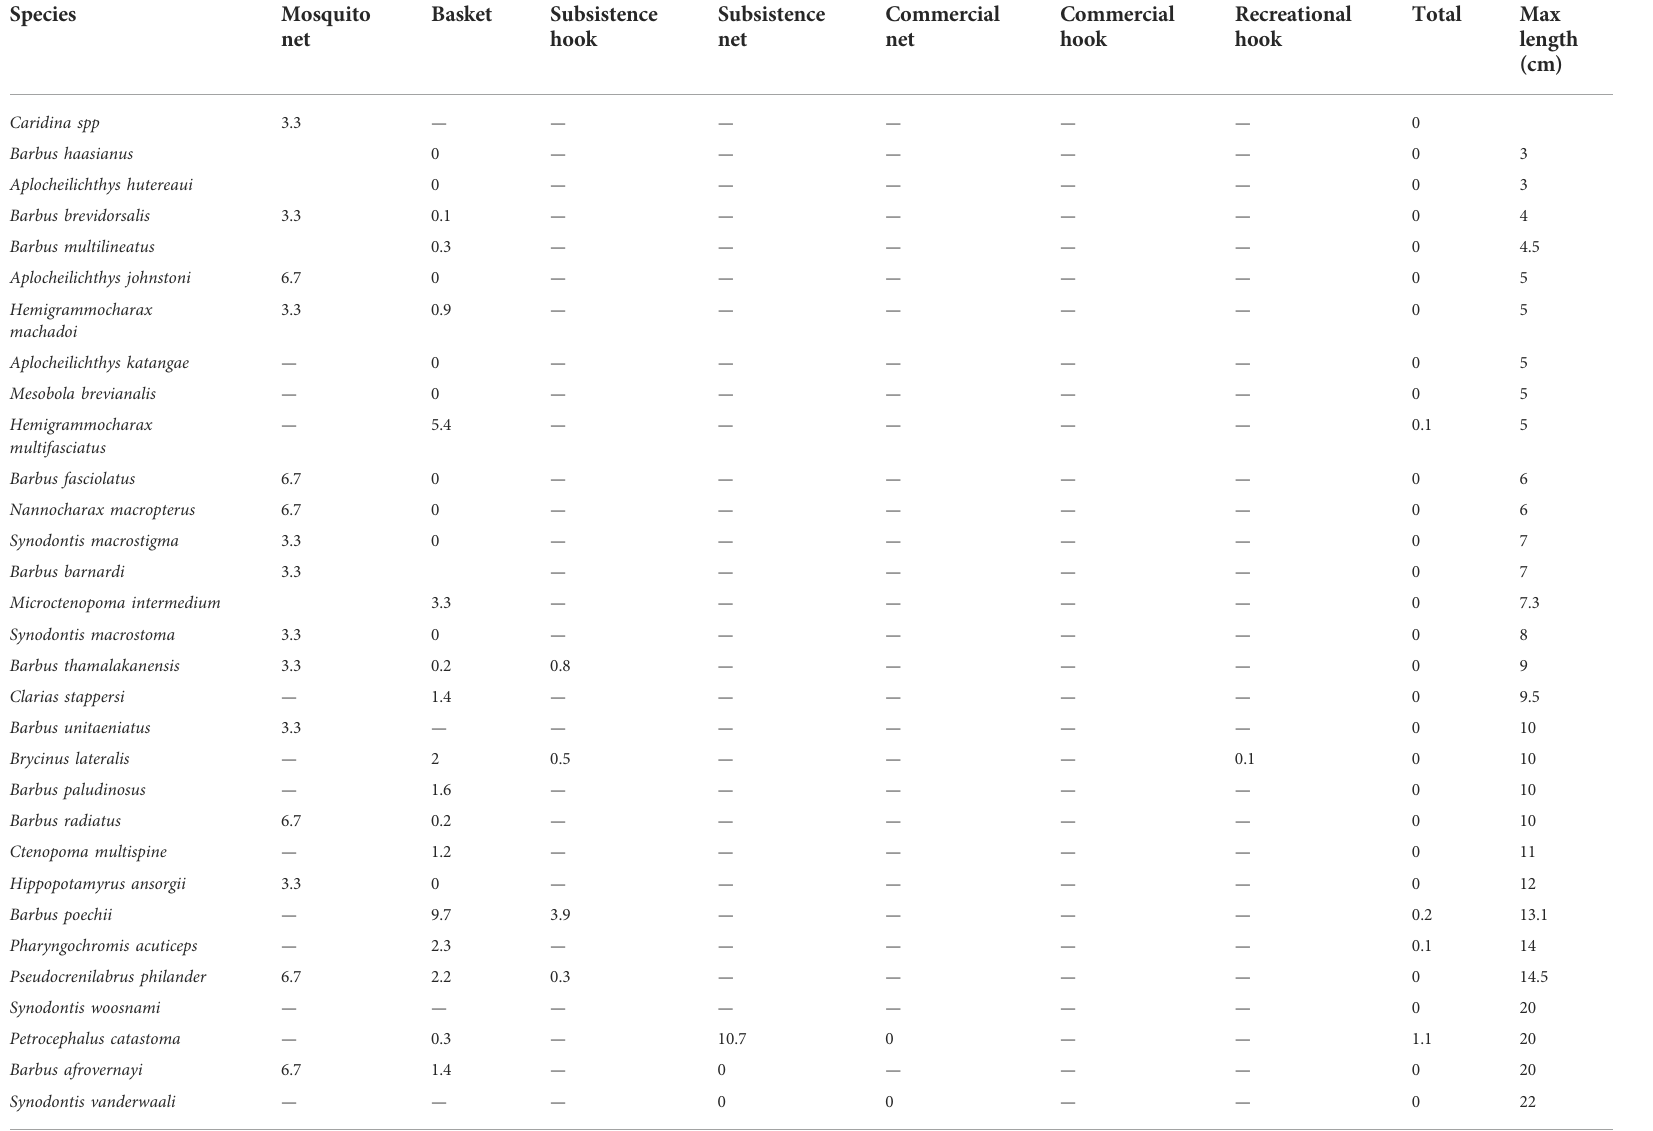
TABLE 2 List of 63 fi sh species caught in the Okavango fi shery and relative abundance (%) in each of the common gear types. Sorted by ascending maximum size as shown in Figure 3.